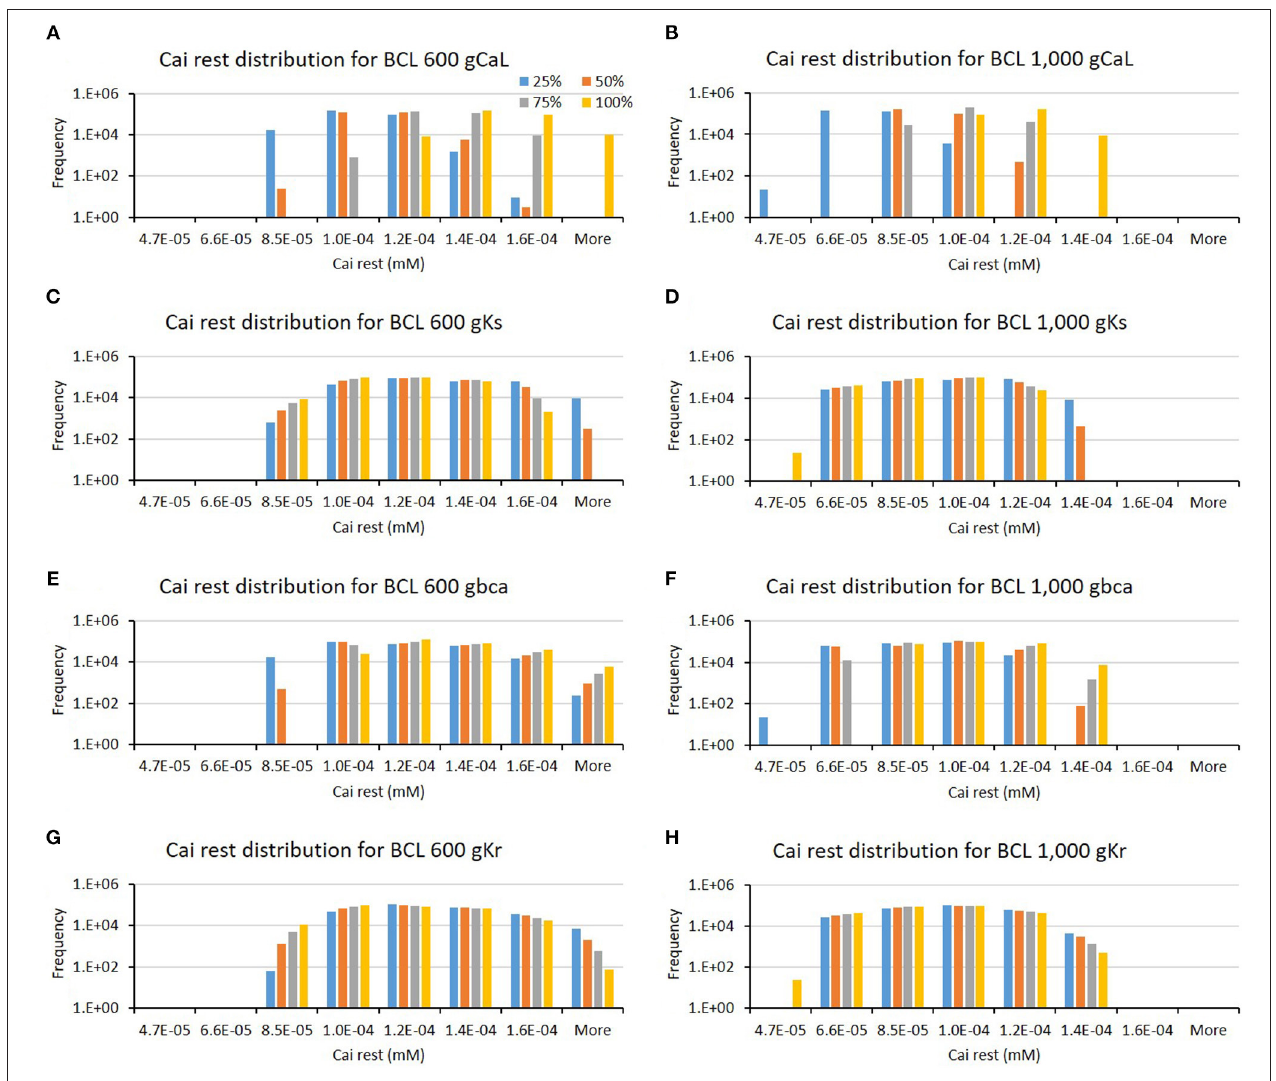
FIGURE 7 | The bar charts show the influence of major ion channels (based on Table 1 ) on the resting Cai concentration [for BCL 600ms (A,C,E,G) and for BCL 1,000ms (B,D,F,H) ]. The x -axis is the resting Cai groups in millimolar, and the y -axis is the frequency (number of appearance of resting Cai groups) in logarithmic scale. Four conductance variations are applied